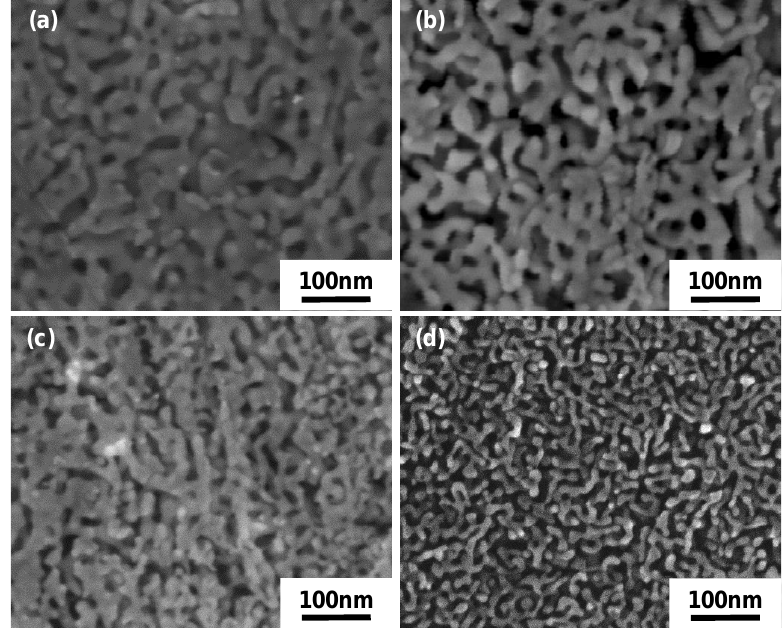
Figure 1. SEM images of NPG produced by dealloying of CR samples with different thickness reductions: ( a ) 0%; ( b ) 60% and ( c ) 90% for a dealloying time of 7 h and ( d ) 98%, for which a shorter dealloying time of 3 h was used to avoid over-corrosion of the sample and to compare the NPG structure of samples with and without post-deformation annealing with the same dealloying time of 3 h.